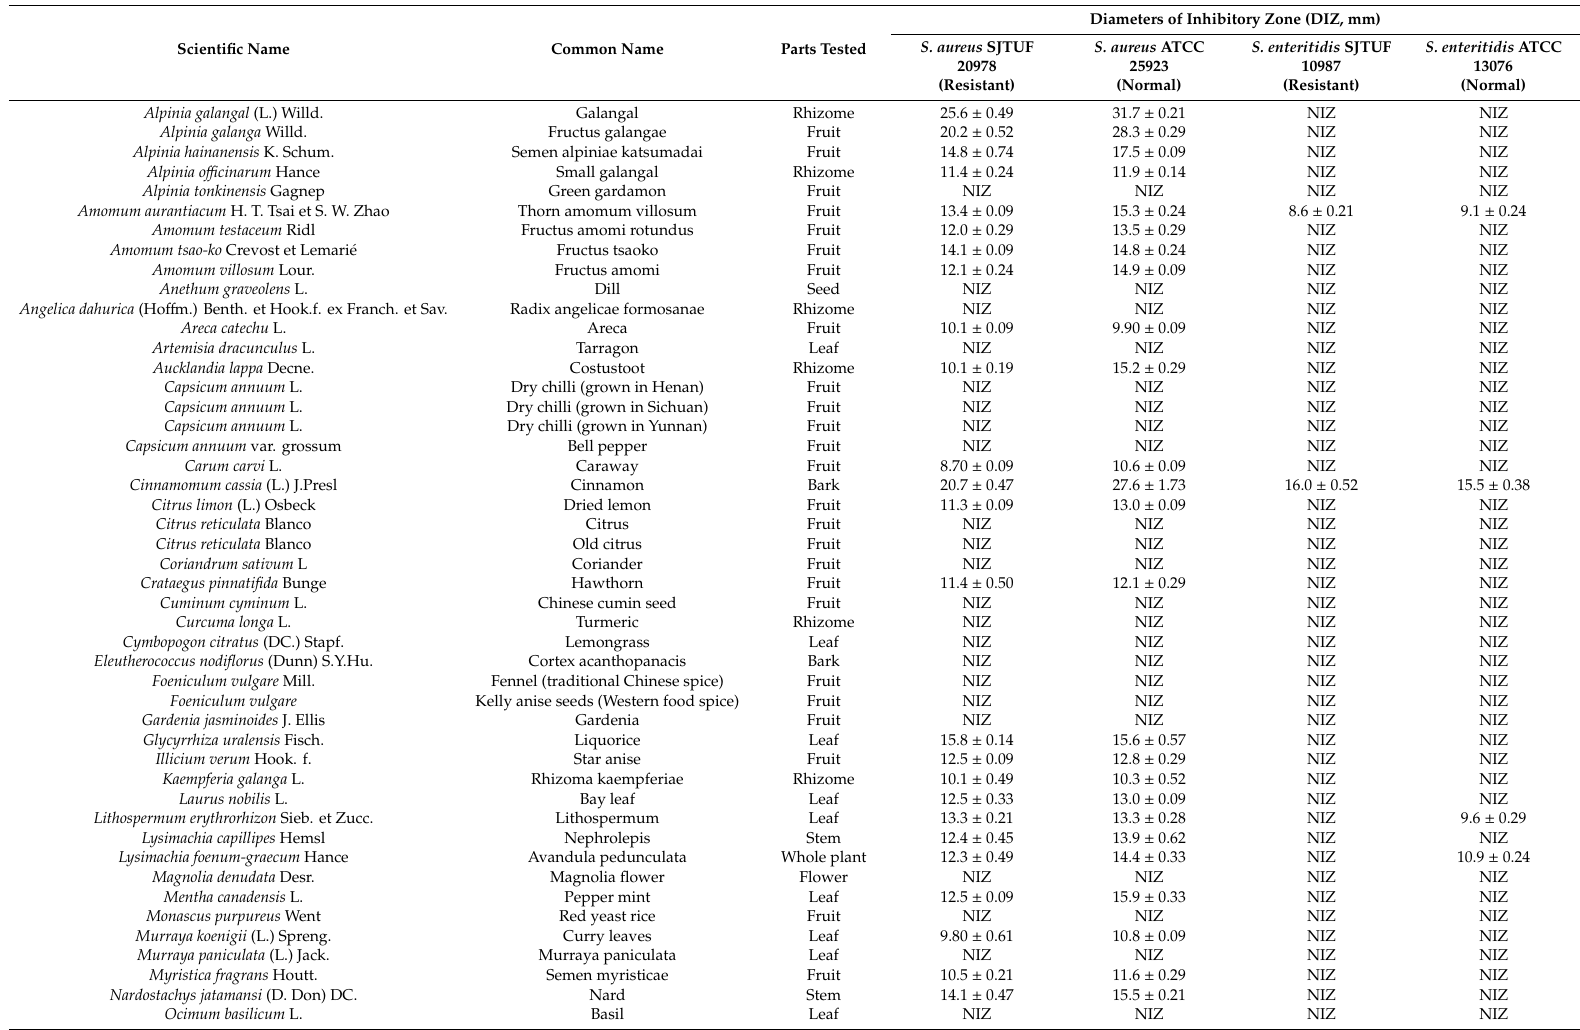
Table 1. Antibacterial properties of 67 spice